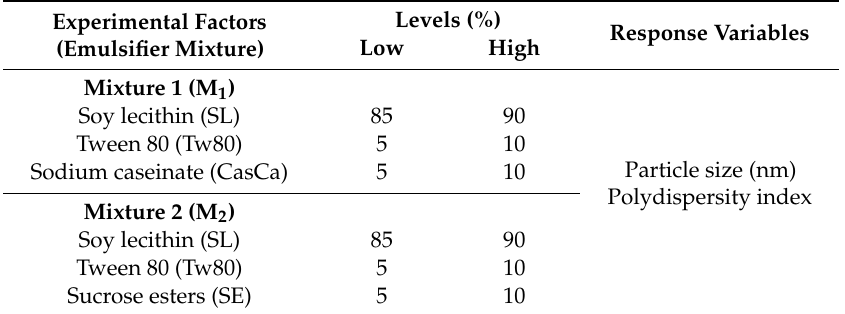
Table 1. Experimental factors, levels and response variables for mixture experimental